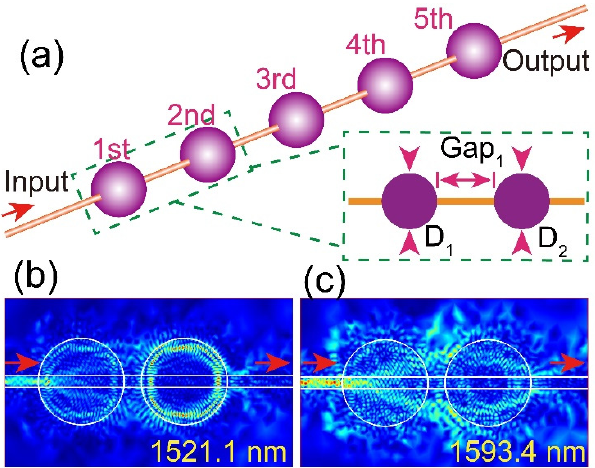
Figure 1. ( a ) The proposed scheme of silica taper-assisted 5 UV-cured adhesive microspheres. Inset shows the cross section of first two microspheres with diameters of D 1 and D 2 , and gap 1 in between. ( b , c ) Electric field distributions of fiber-optic 2-spheres sensor with D 1 = D 2 = 15 µm, gap 1 = 3 µm, and different input wavelengths.